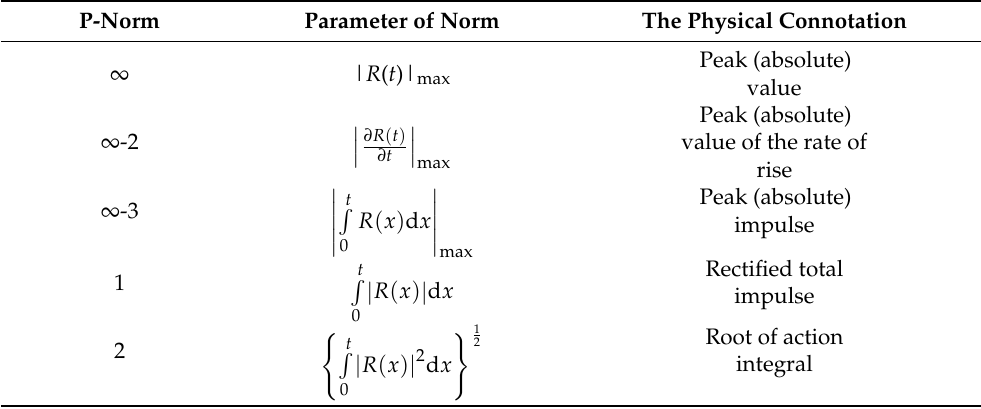
Table 1. 5 electromagnetic norms typically used for waveform characterization refer to